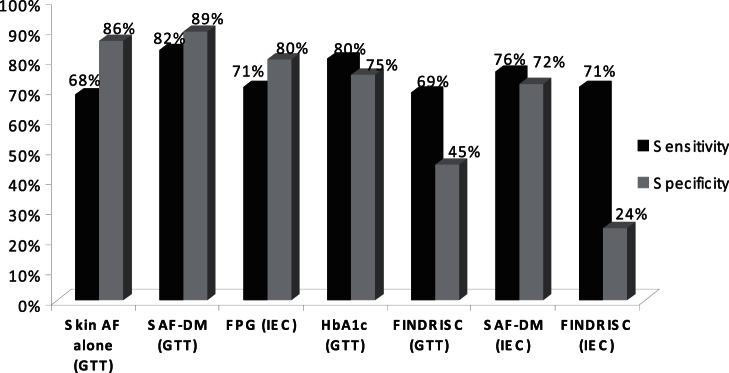
Sensitivity and specificity of skin AF alone, skin AF based decision tree (SAF-DM), FPG, HbA1c and FINDRISC for correct classification of diabetes/IGT versus normal, using OGTT based WHO criteria, or for DM/suspicion DM using HbA1c based IEC 2009 criteria.